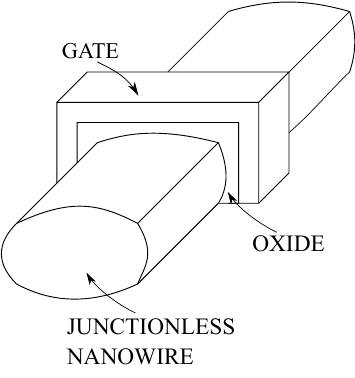
Figure 2. Structure of the junctionless nanowire.